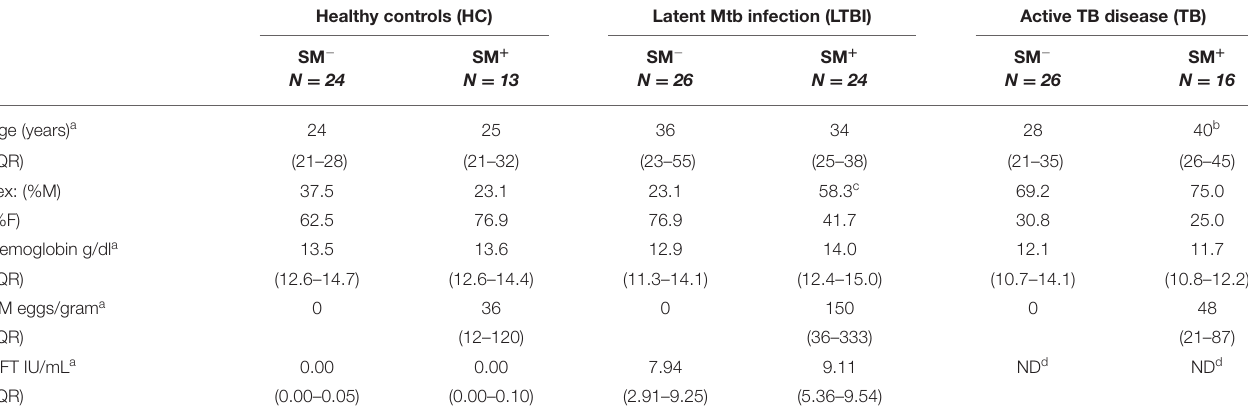
TABLE 1 | Characteristics of study